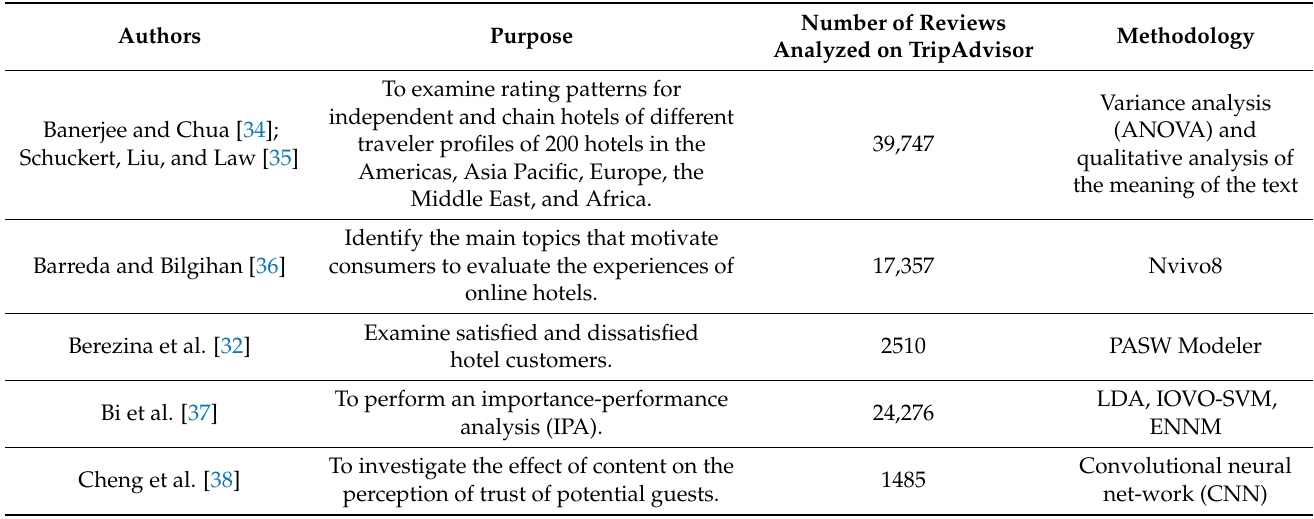
Table 1. Literature on online analysis of TripAdvisor